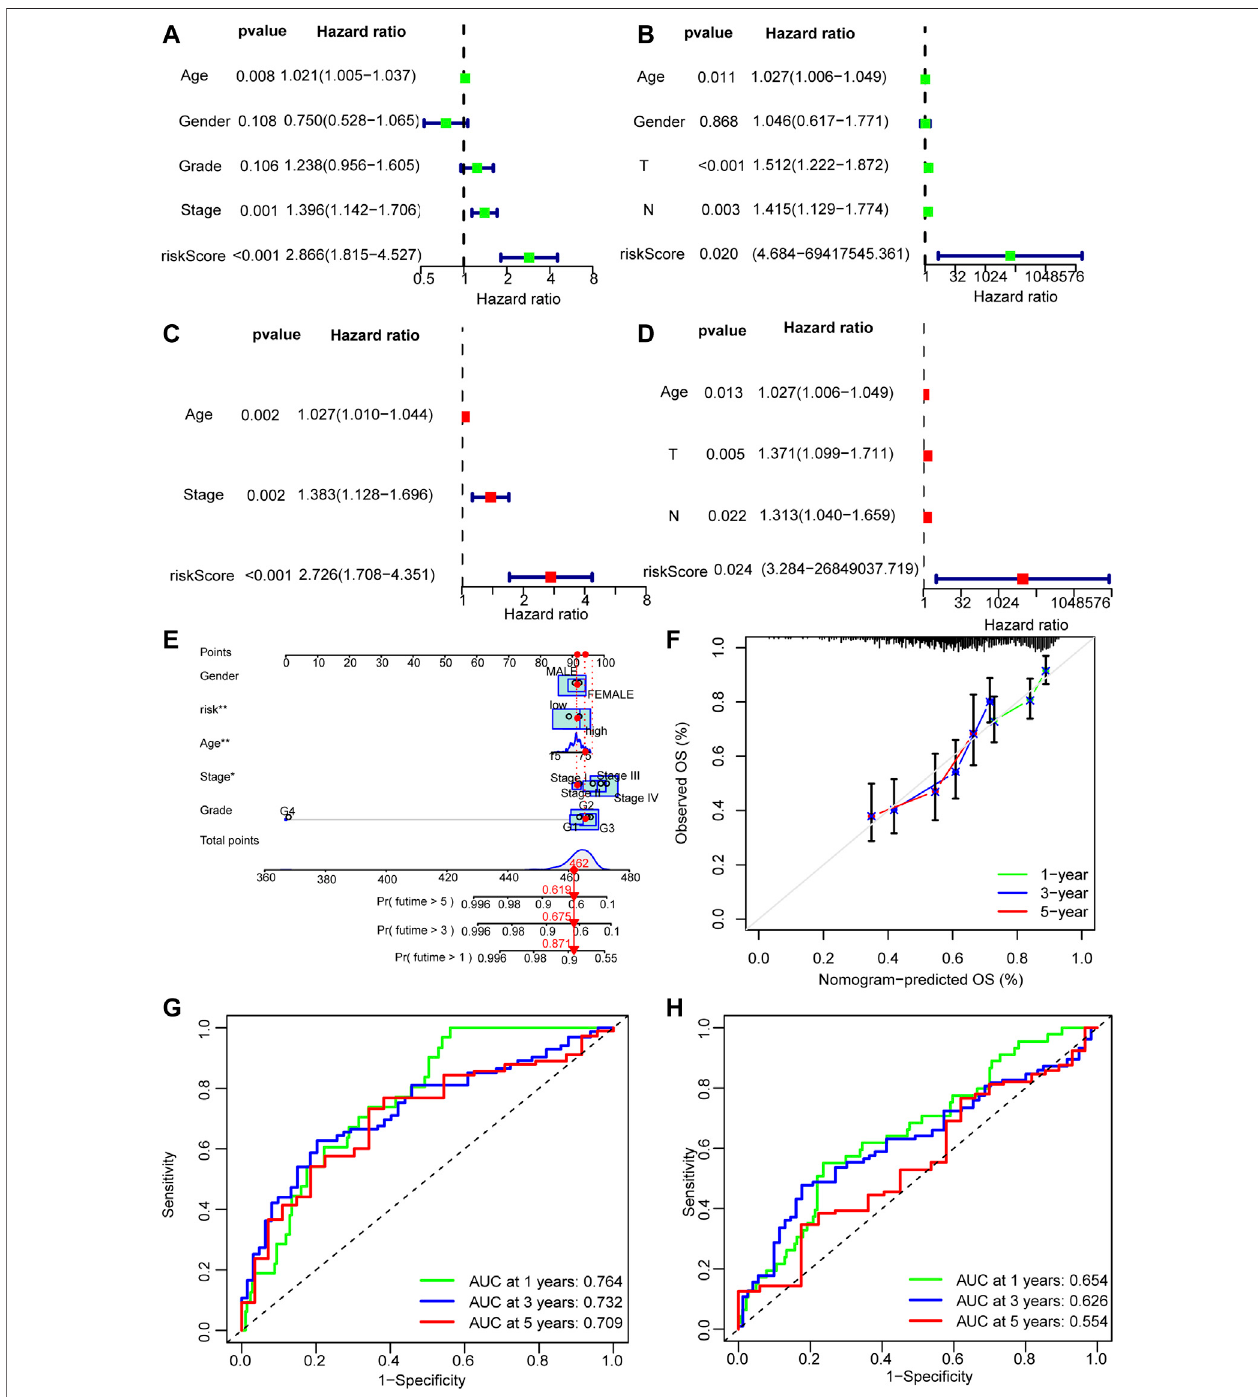
FIGURE6| Nomogramofthemodel. (A – D) UnivariateandmultivariateCoxanalysesofclinicopathologicalcharacteristicsandriskscorewithoverallsurvival(OS)in the training and validation sets. (E) The nomogram that integrated the risk score, age, and tumor stage to predict OS. (F) The calibration curves for OS. (G,H) The ROC curves of the low-risk and the high-risk groups of the training and validation sets.